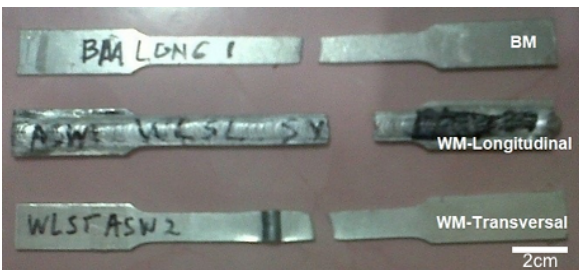
Figure 11: Typical fractured specimens from tensile tests, showing the fracture location of the AL6061 BM and